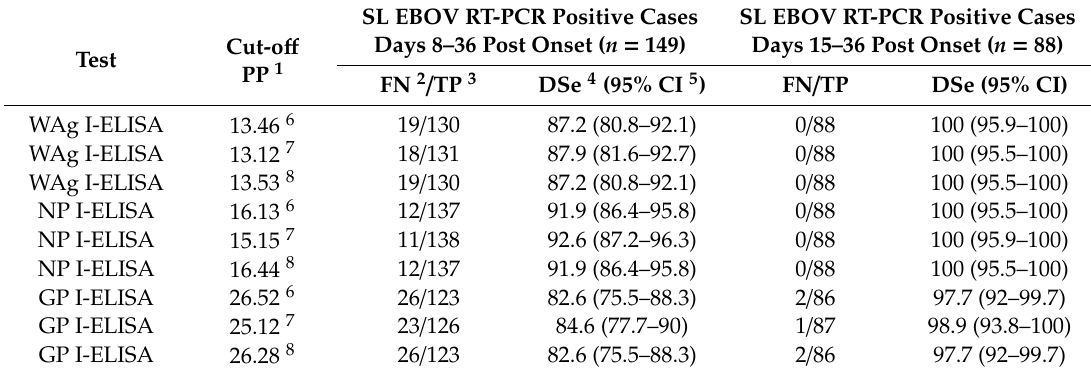
Table 4. Diagnostic sensitivity of a whole antigen (WAg), nucleocapsid (NP), and glycoprotein (GP) I-ELISAs for the detection of anti-IgG EBOV antibody in humans.